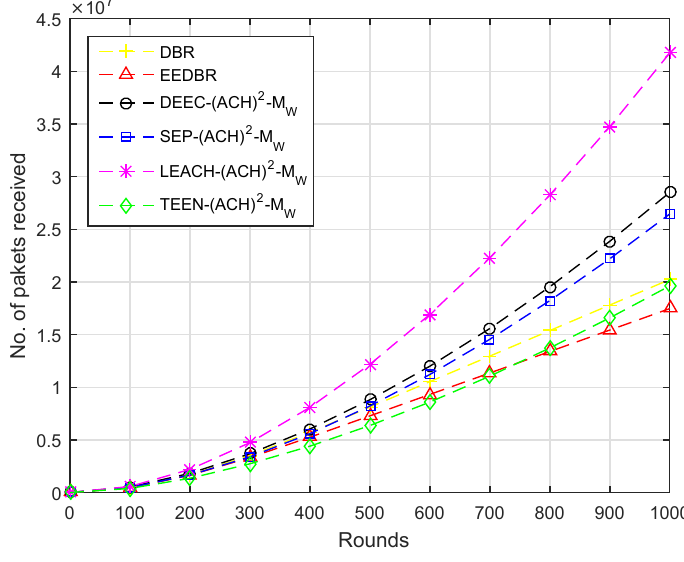
Figure 12. Number of Packets Received at